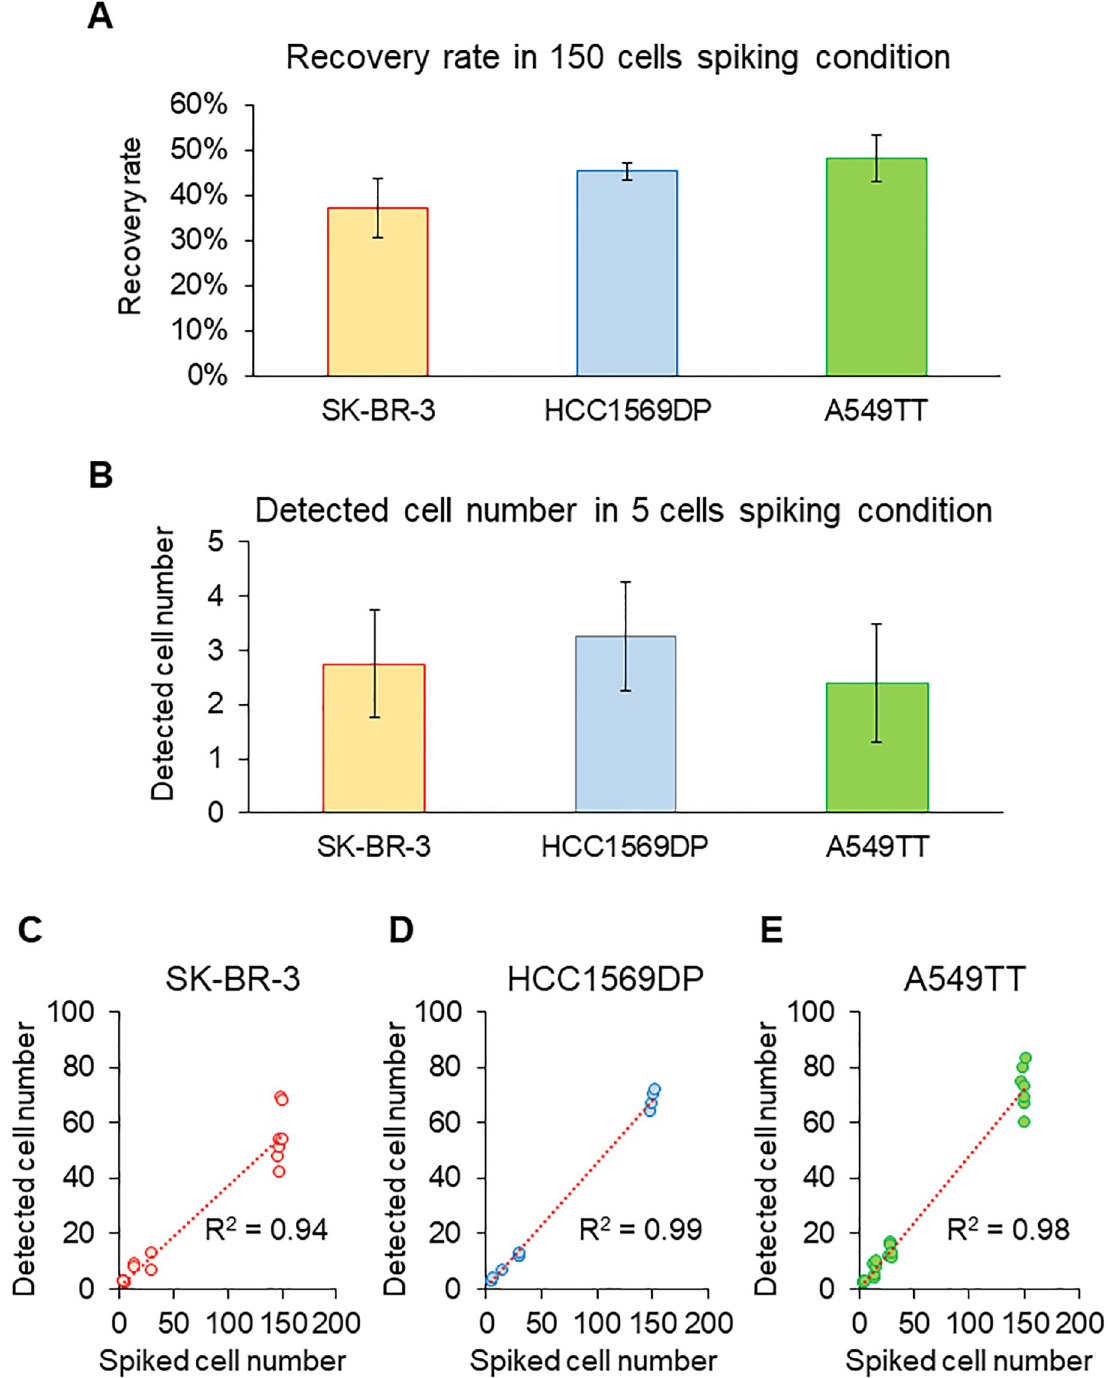
Fig 3. Recovery rate, lower limit of detection, and linearity. (A) Recovery rates of SK-BR-3 (n = 7), HCC1569DP (n = 4), and A549TT (n = 7). Recovery rate was calculated for 150 cells spiked into whole blood. Data are presented as mean ± 1 standard deviation (SD). (B) Lower limits of detection of SK-BR-3 (n = 4), HCC1569DP (n = 4), and A549TT (n = 5). Lower limits of detection were calculated as the minimum spiking condition where the value obtained by subtracting 2 SD from the average number of detected cells is � 1. Data are presented as mean ± 2 SD. (C–E) Linearity of SK-BR-3 (n = 21), HCC1569DP (n = 19), and A549TT (n = 26). Linearity was evaluated by the coefficient of determination in the first-order linear regression equation of a scatter diagram that plots numbers of detected cells against numbers of spiked cells. https://doi.org/10.6084/m9.figshare.12433265.v3.